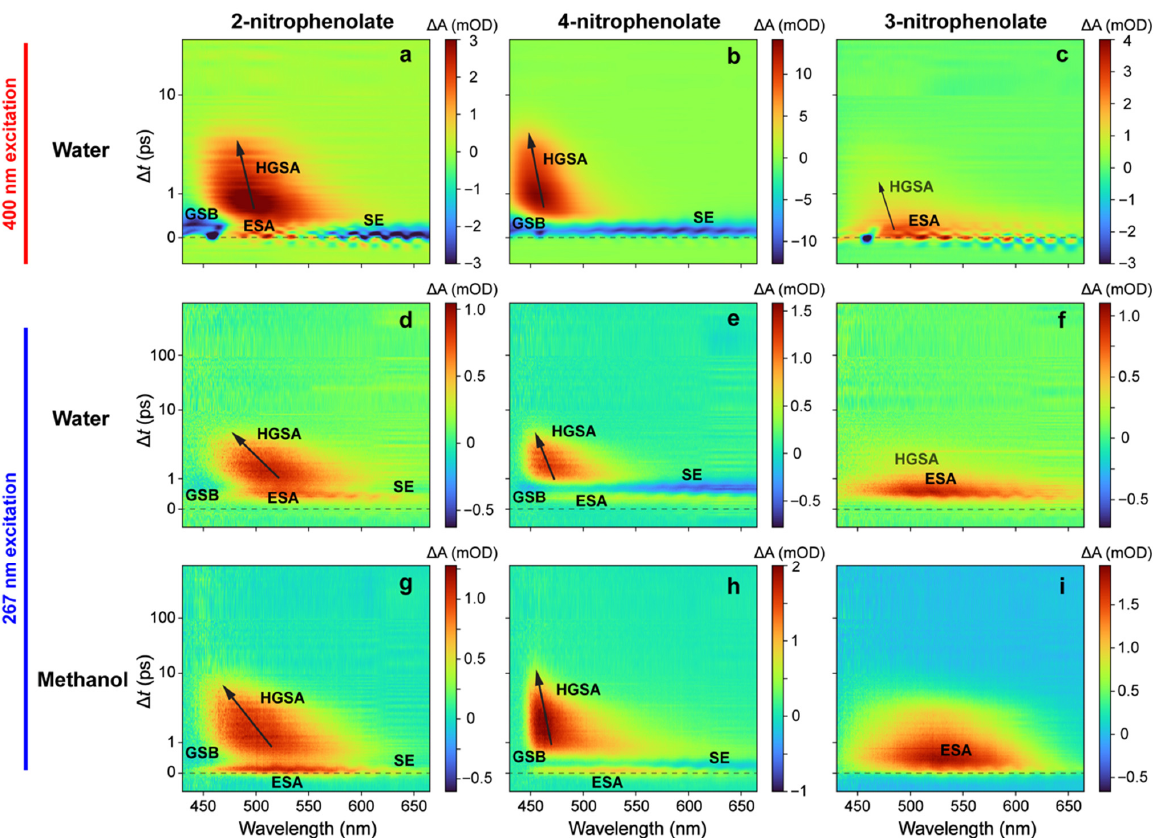
Figure 2. Semilogarithmic contour plots of fs-TA spectra of various nitrophenolates in water and methanol. The logarithmic scaling is for time points after 1 ps. The 400 nm excitation data for ( a ) 2NP − , ( b ) 4NP − , and ( c ) 3NP − are compared with the 267 nm excitation data for ( d ) 2NP − , ( e ) 4NP − , and ( f ) 3NP − in water, as well as the 267 nm excitation data for ( g ) 2NP − , ( h ) 4NP − , and ( i ) 3NP − in methanol, respectively. Longer time windows are shown for panels ( d – i ) to expose the weak yet discernible positive signal after a ~100 ps time delay for nitrophenolates after 267 nm excitation compared to 400 nm excitation (panels ( a – c )). For the methanol data, the spectra shown have an average of five pre-excitation spectra subtracted to remove the nonzero background (see Section 2.3 below for details). Major TA bands are labeled in each panel, with prominent spectral shifts indicated by the tilted black arrows. Time zero of photoexcitation is denoted by the horizontal dashed line in each panel. Table 1. Lifetimes and associated states from global analysis of fs-TA spectra of three nitropheno- lates in two solvents following excitation at two different wavelengths *.